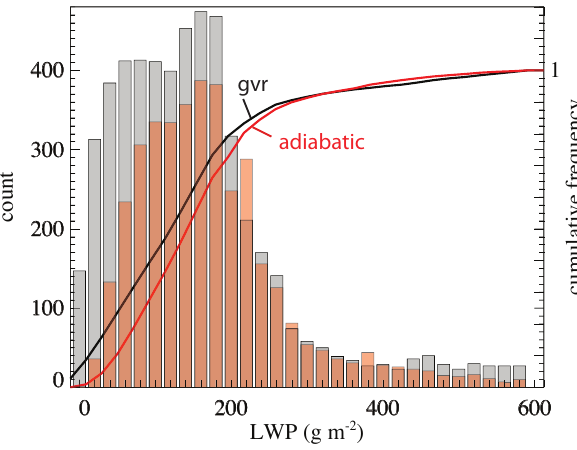
Fig. 9. Distribution of GVR-retrieved (black) and adiabatic (red) LWPs from all nine subcloud legs of the 21 October research flight (RF3). Total number of samples is 5471 and 4003 for the GVR and adiabatic calculation respectively. LWP bins of 20gm − 2